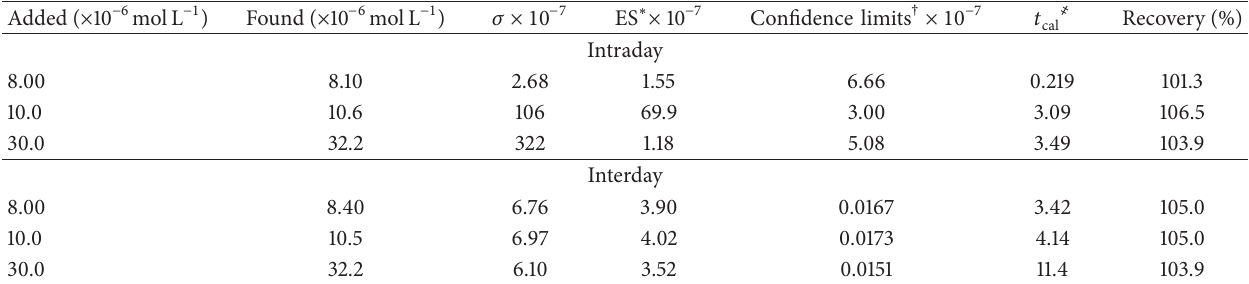
Table 4: Analysis to assess the precision and accuracy of the proceeding developed for the determination of AOF intraday and interday. Added ( × 10 −6 molL −1 )